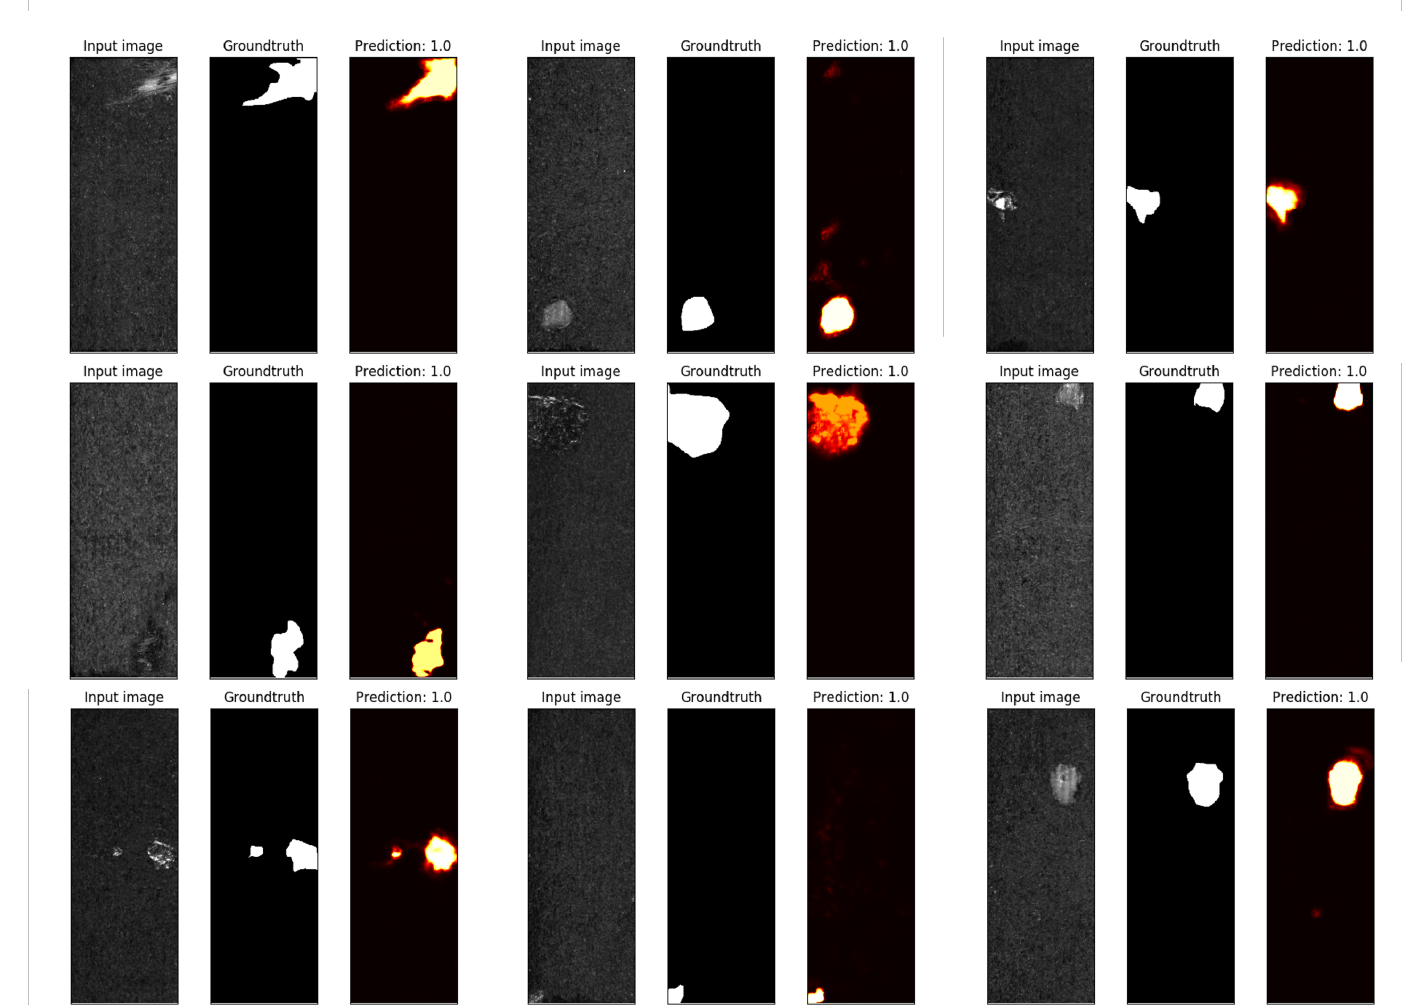
Figure 11. Examples of KolektorSDD2 defect segmentation